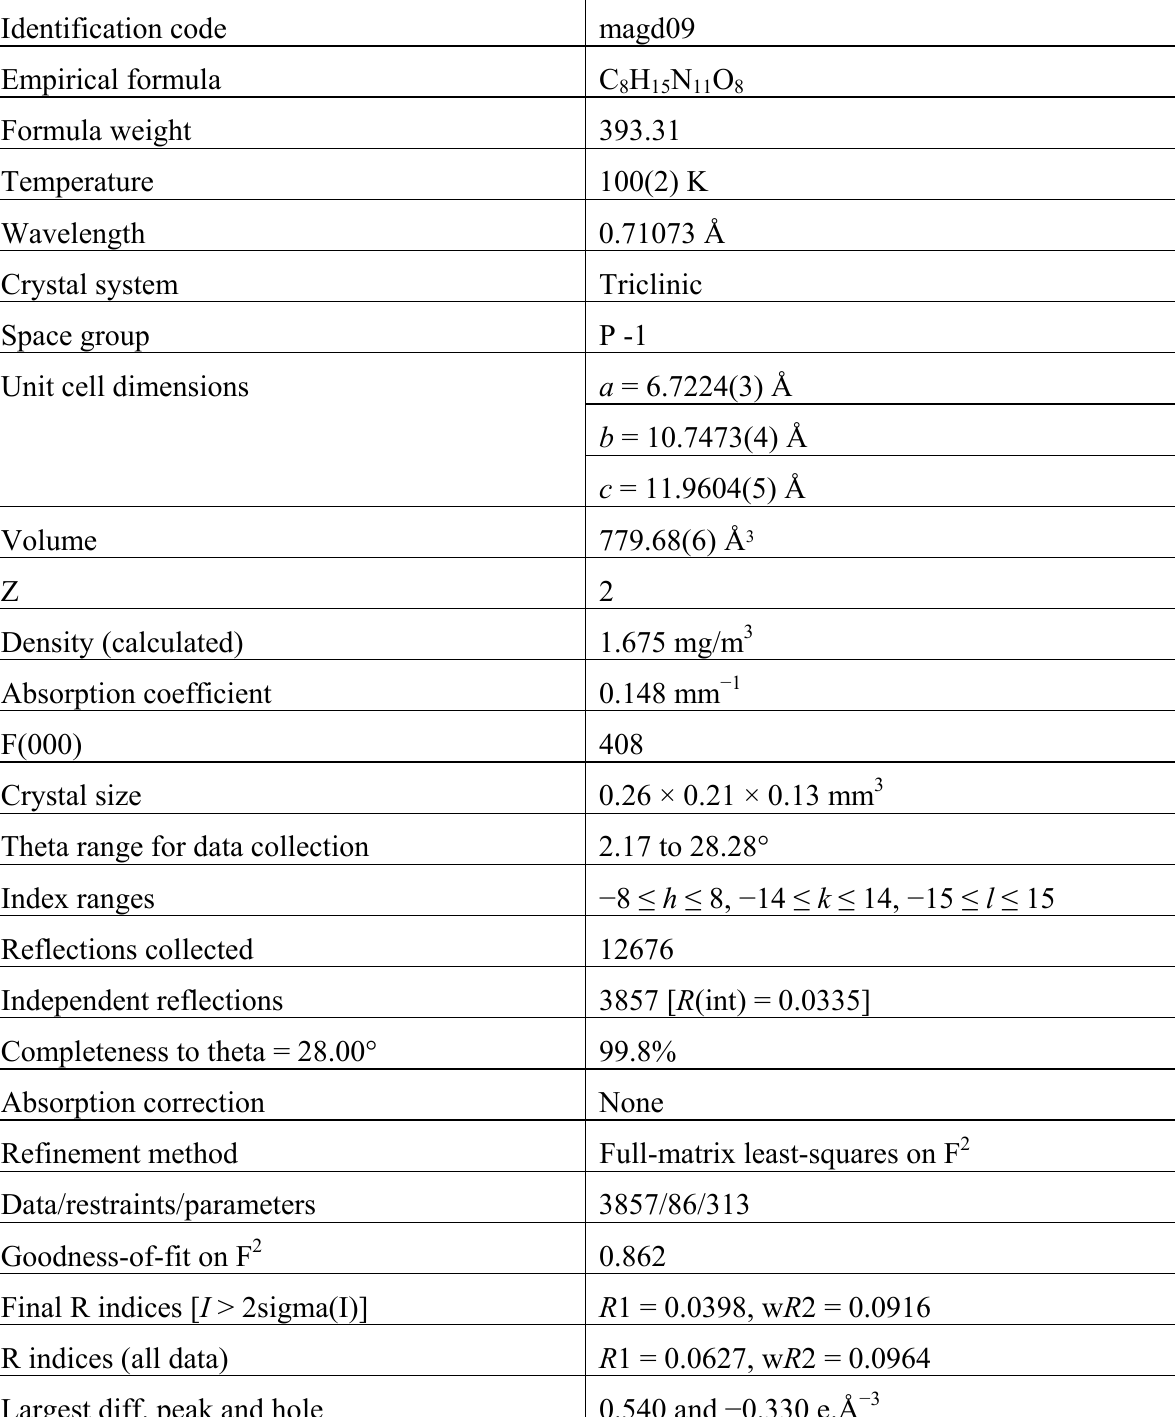
Table 1. Crystal data and structure refinement for aminoguanidinium